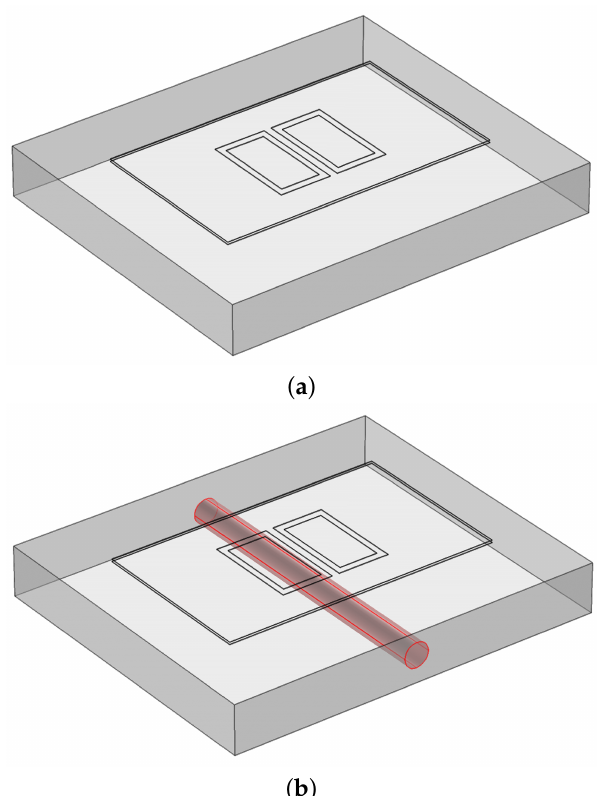
Figure 3. Model geometry for a concrete slab ( a ) without and ( b ) with rebar.